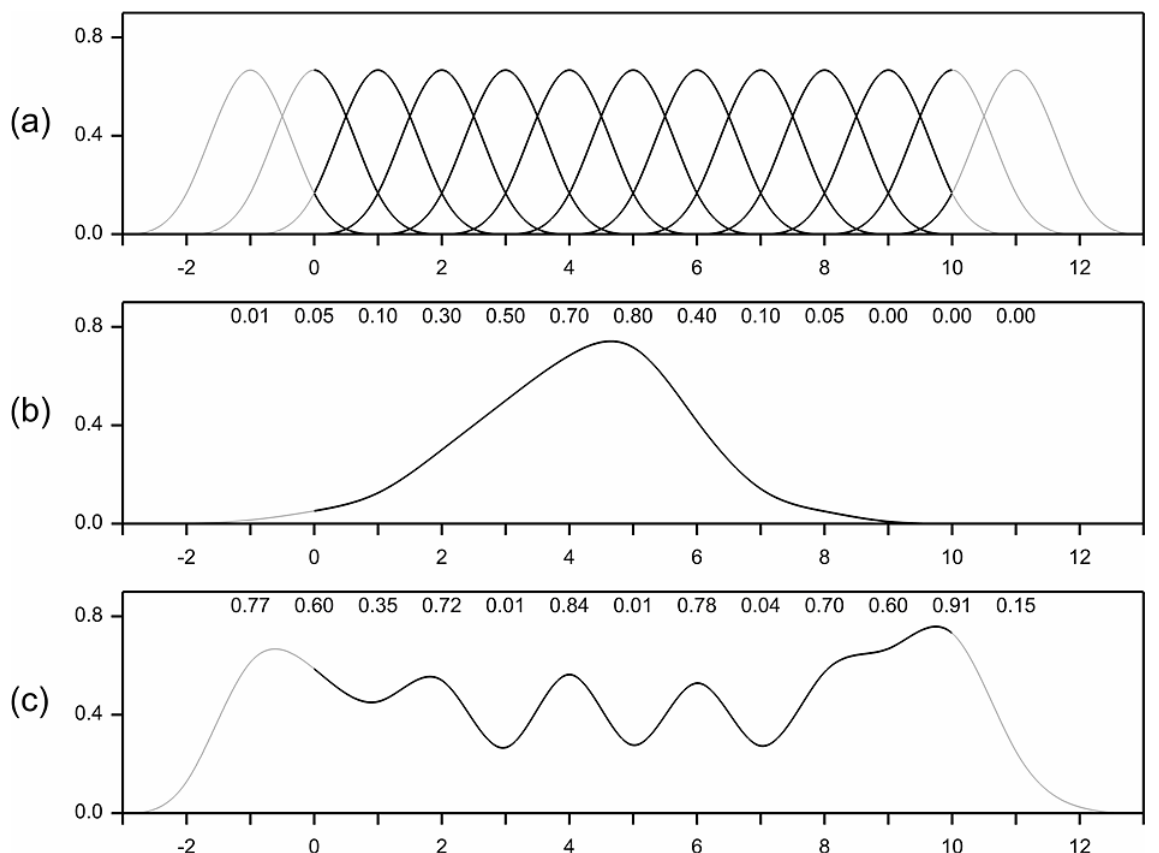
Figure 1. (a) Cubic B splines on the interval [0, 10] with equidistant knots at all integer values; (b) and (c) display